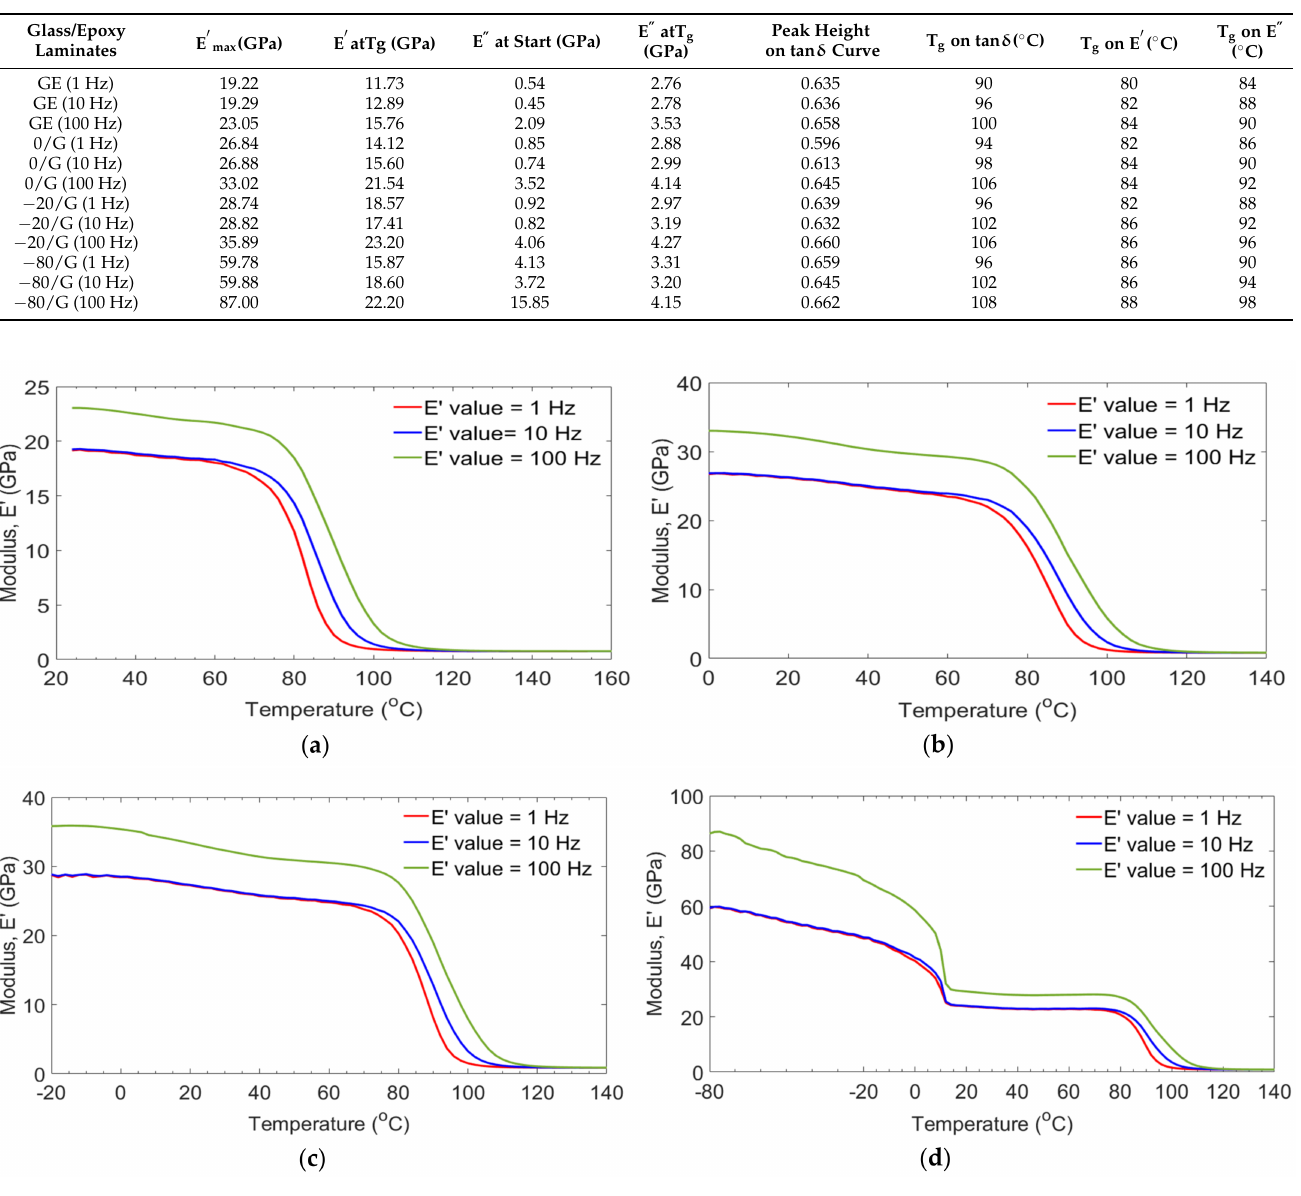
Table 4. Maximum storage modulus, loss modulus, the peak of tan δ and T g of laminates.